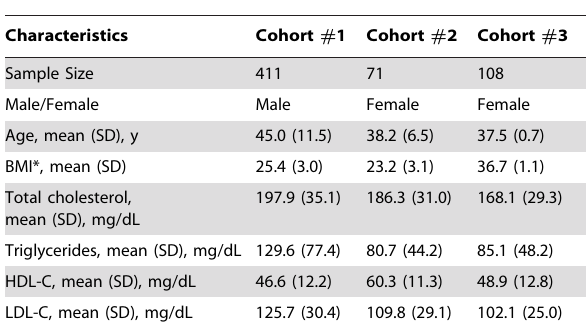
Table 1. Baseline characteristics of study subjects (n= 590).